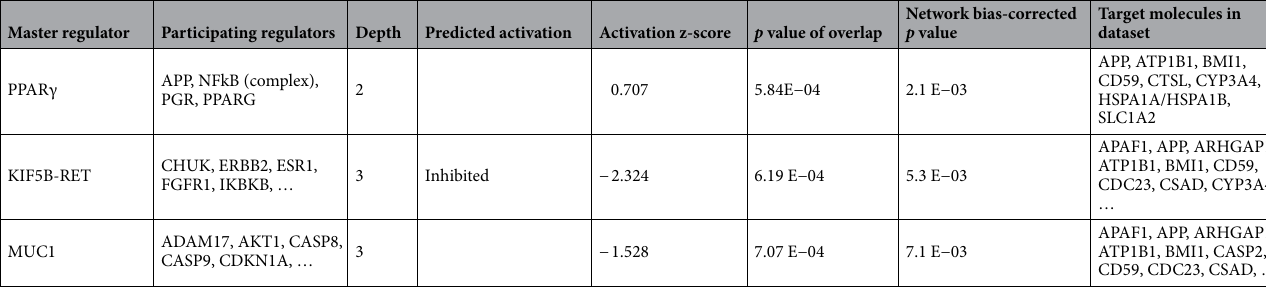
Table 1. Top 3 causal networks predicted by IPA 34 explaining expression changes in the input dataset. The